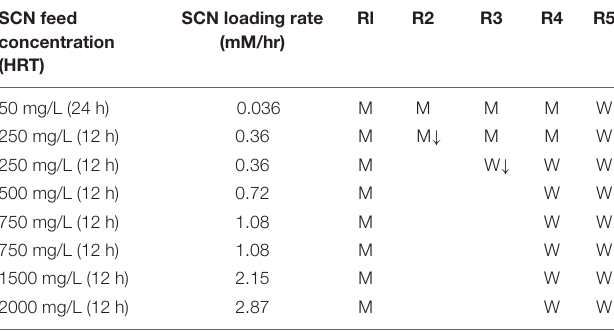
TABLE 1 | Summary of experimental